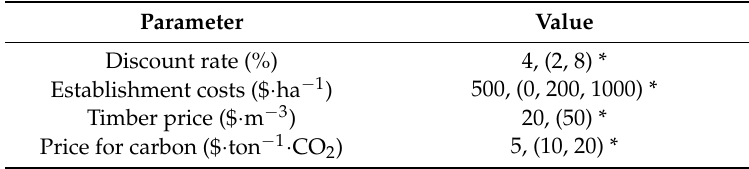
Table 1. Parameter values used in the baseline scenario and sensitivity